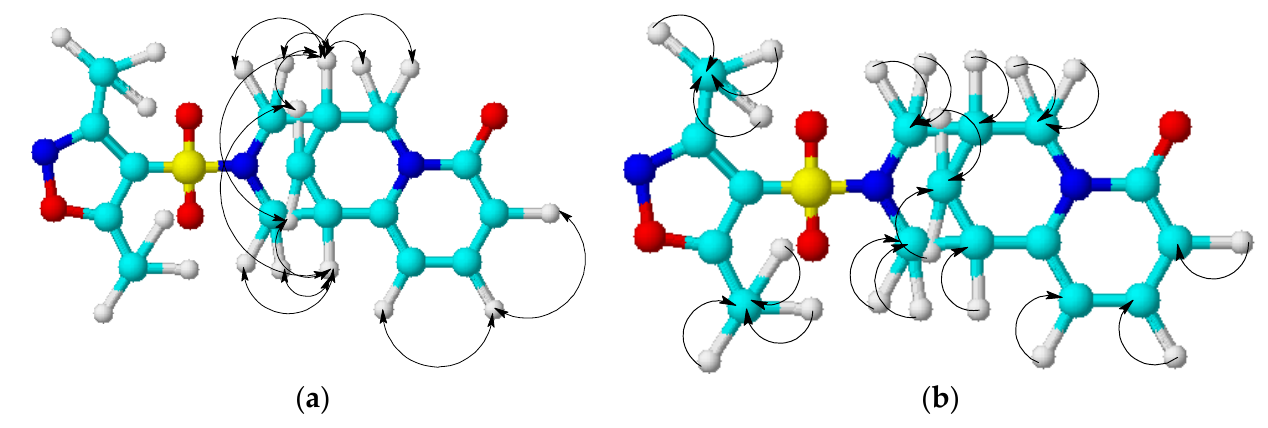
Figure 1. The structural correlations in COSY ( a ) and HMQC ( b ) spectra of compound 2. The 1 H- 1 H COSY spectra of compound 2 have demonstrated the spin-spin correlations